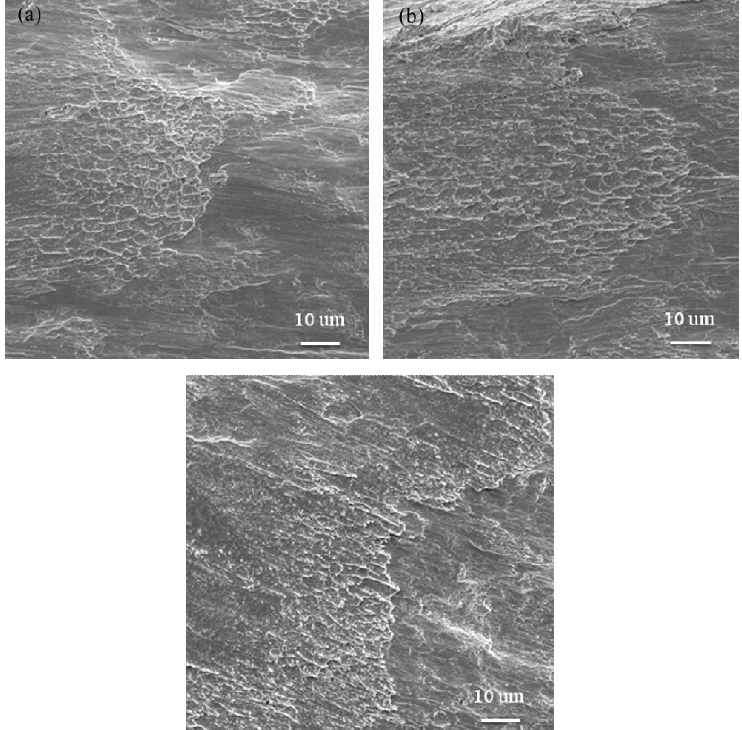
Figure 7. SEM fracture surface of Zr-based metallic glass specimens deformed at strain rates of ( a ) 2.2 × 10 3 s − 1 ; ( b ) 3.2 × 10 3 s − 1 ; and ( c ) 5.1 × 10 3 s − 1